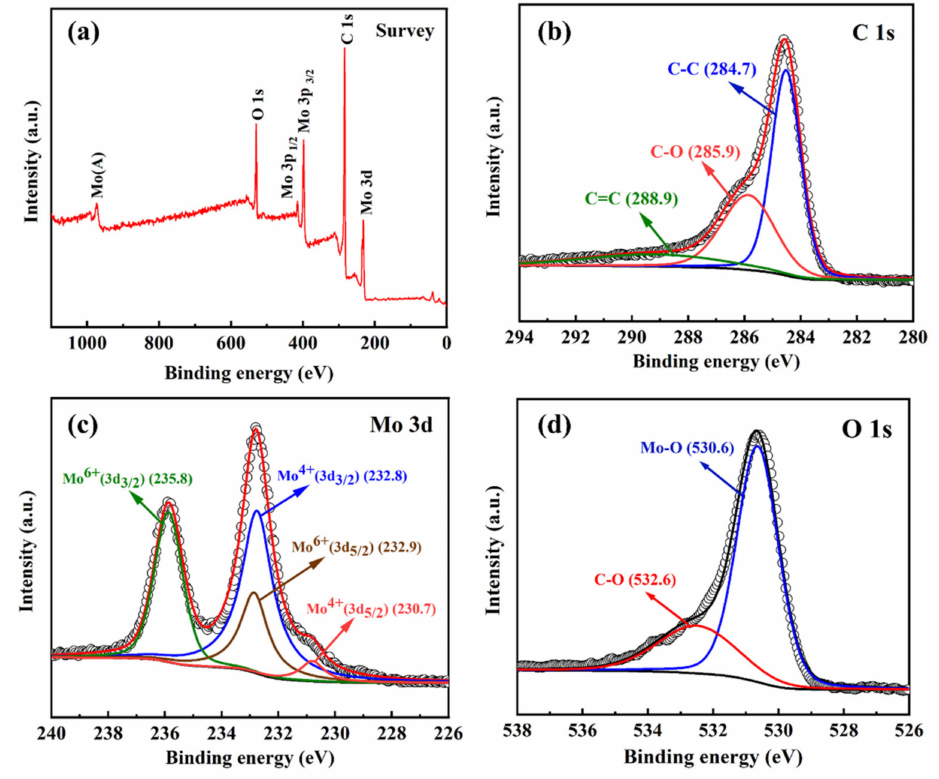
Figure 5. XPS survey ( a ), C 1 s ( b ), Mo 3 d ( c ) and O 1 s ( d ) spectra curves of the MoO 2 /C nanofiber